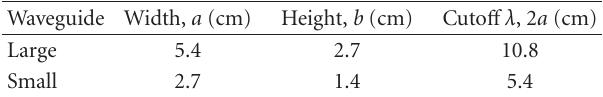
Table 1: Reference waveguide antenna dimensions and cuto ff wave-